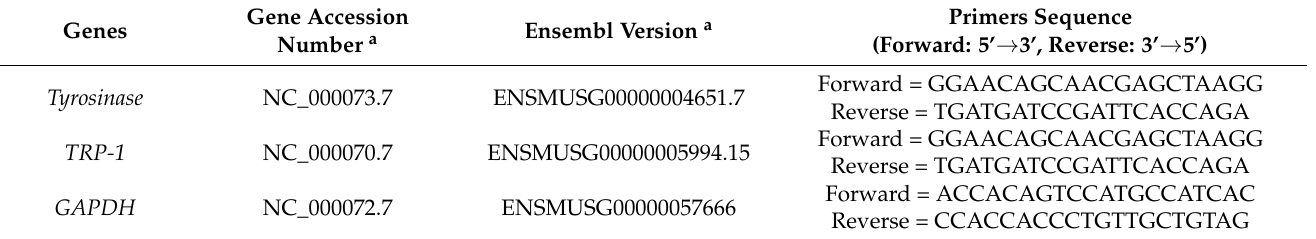
Table 1. List of primer sets used for